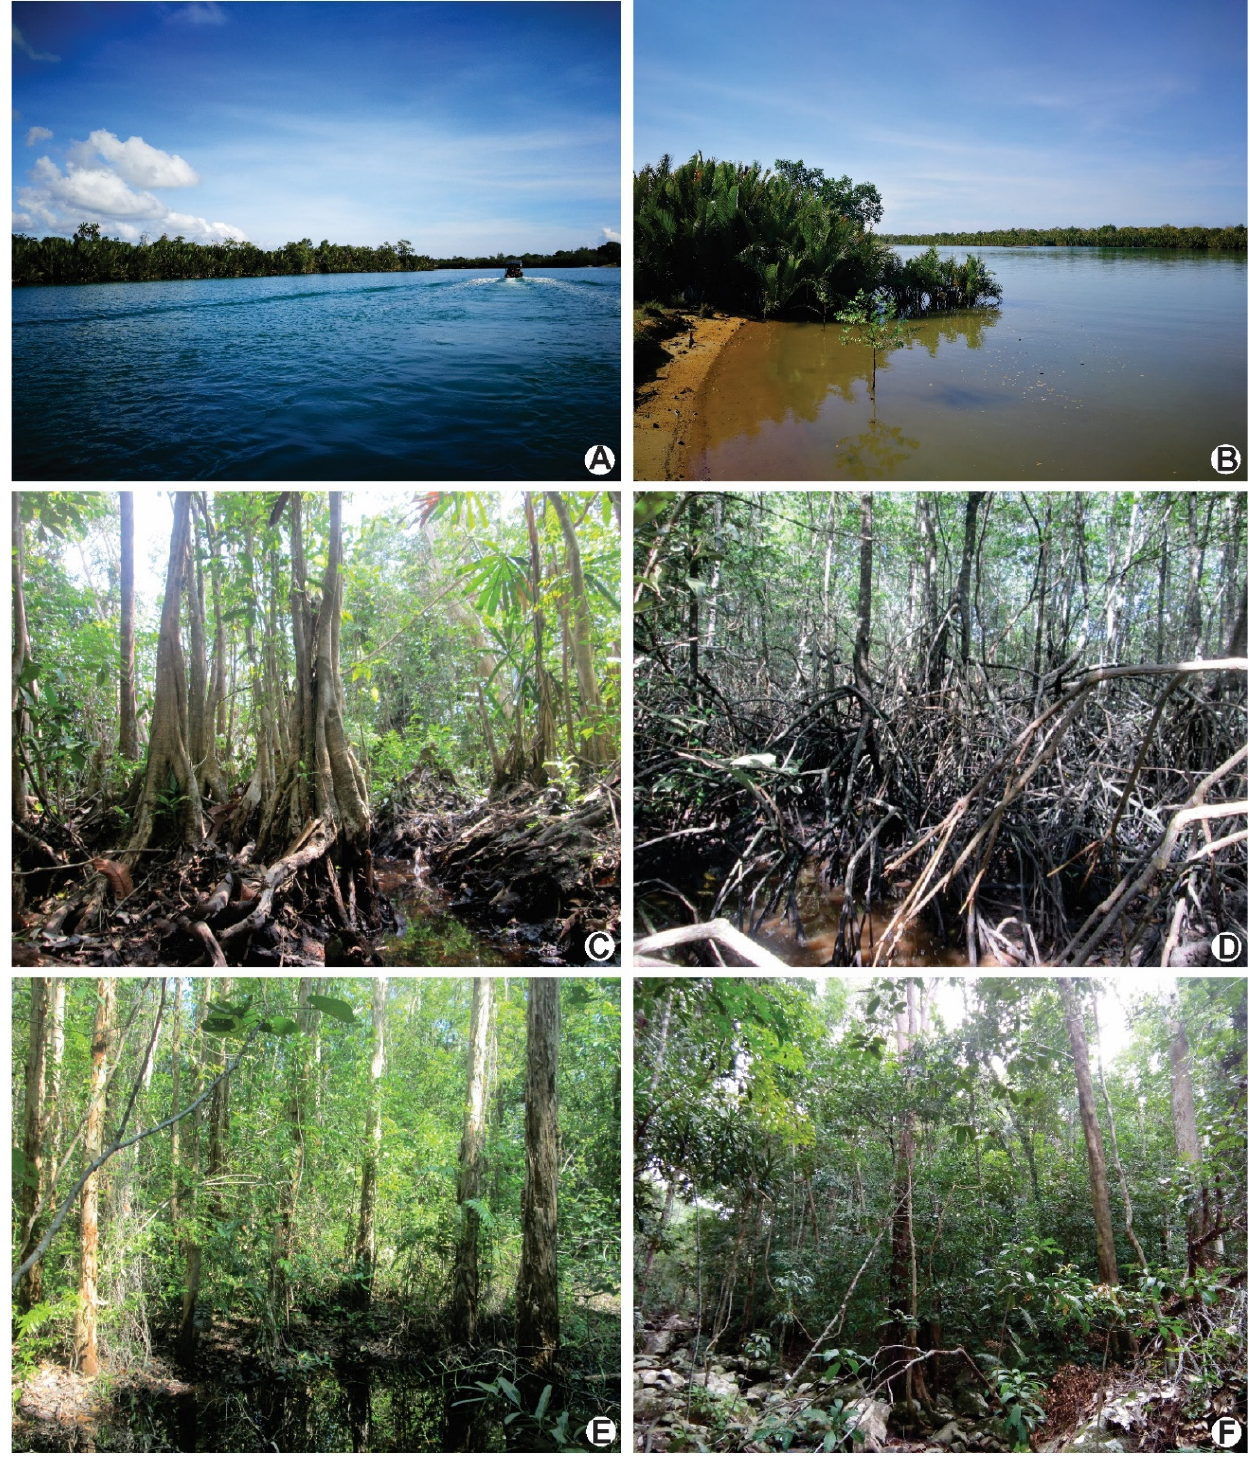
Figure 2. Different habitats at the study areas. ( A , B ) Setiu River, one of the four main rivers in Setiu Wetlands; ( C ) freshwater swamp forest; ( D ) mangrove forest; ( E ) Melaleuca swamp forest, ( F ) lowland dipterocarp forest in Pulau Redang.